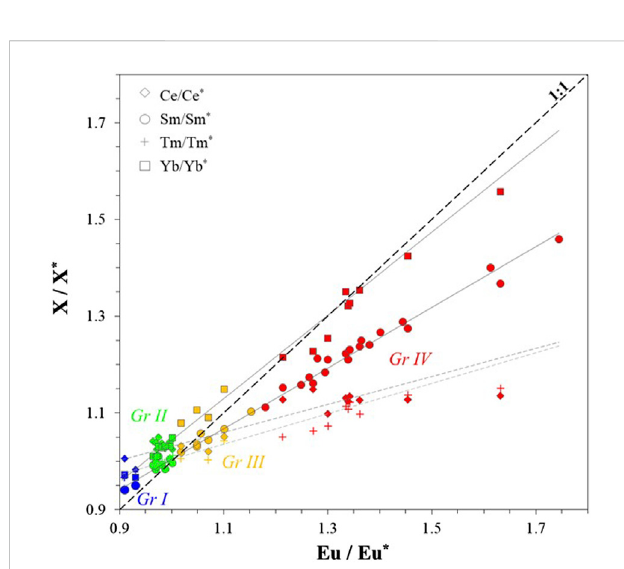
FIGURE 8 RelationshipbetweenEu/Eu*andrelatedREYanomaliescalculated for the core riverbank samples at BETHUP location. The color refers to the group of REY de fi ned in Figure